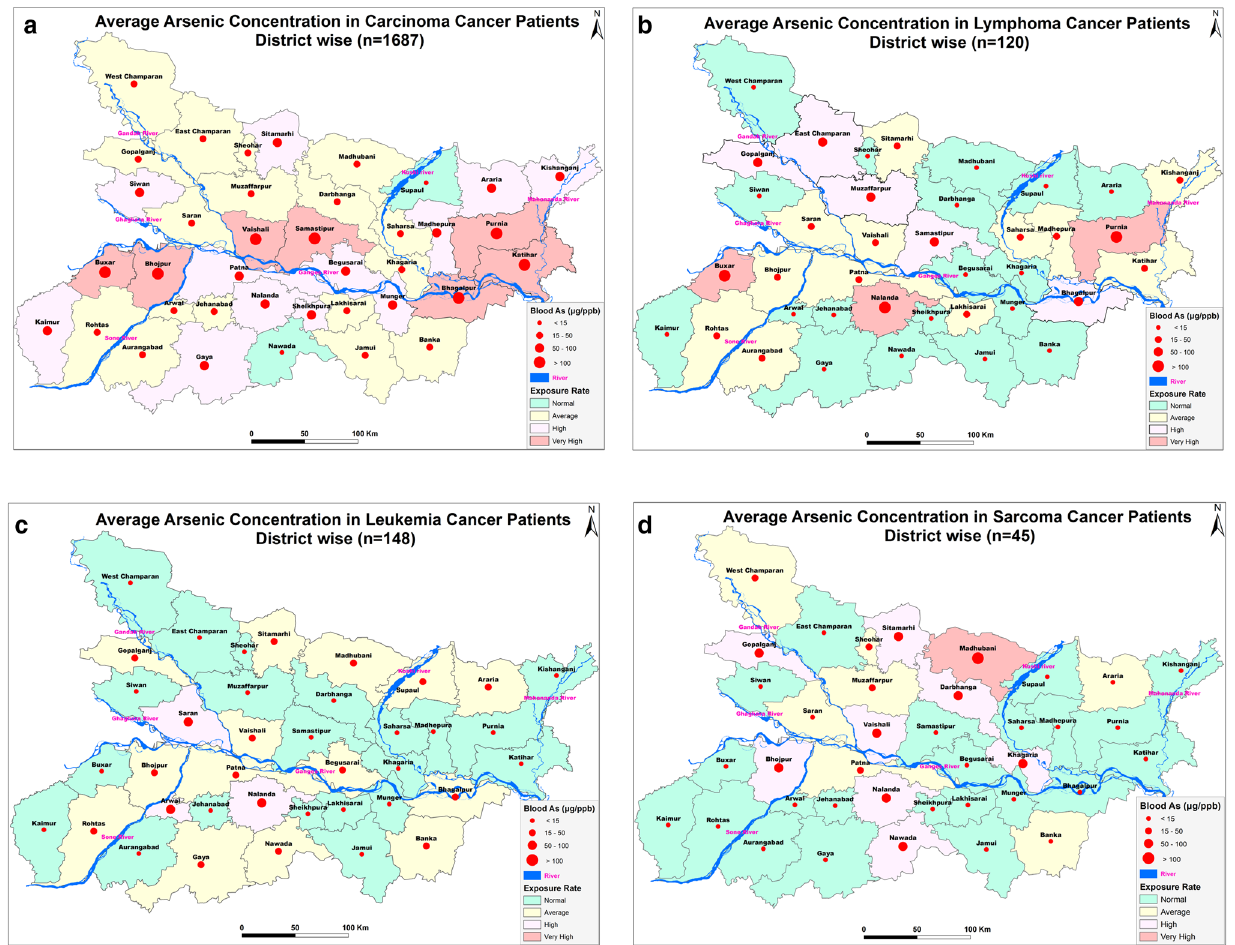
Figure 18. ( A ) Geospatial distribution of Carcinoma Cancer patients with Average Blood Arsenic Concentration [Base map extracted from OpenStreetMap—(http://downl oad.geofa brik.de/asia/india .html) using ArcMap10.5.1]. ( B ) Geospatial distribution of Lymphoma Cancer patients with Average Blood Arsenic Concentration [Base map extracted from OpenStreetMap—(http://downl oad.geofa brik.de/asia/india .html) using ArcMap10.5.1]. ( C ) Geospatial distribution of Leukemia Cancer patients with Average Blood Arsenic Concentration. [Base map extracted from OpenStreetMap—(http://downl oad.geofa brik.de/asia/india .html) using ArcMap10.5.1]. ( D ) Geospatial distribution of Sarcoma Cancer patients with Average Blood Arsenic Concentration. [Base map extracted from OpenStreetMap—(http://downl oad.geofa brik.de/asia/india .html) using